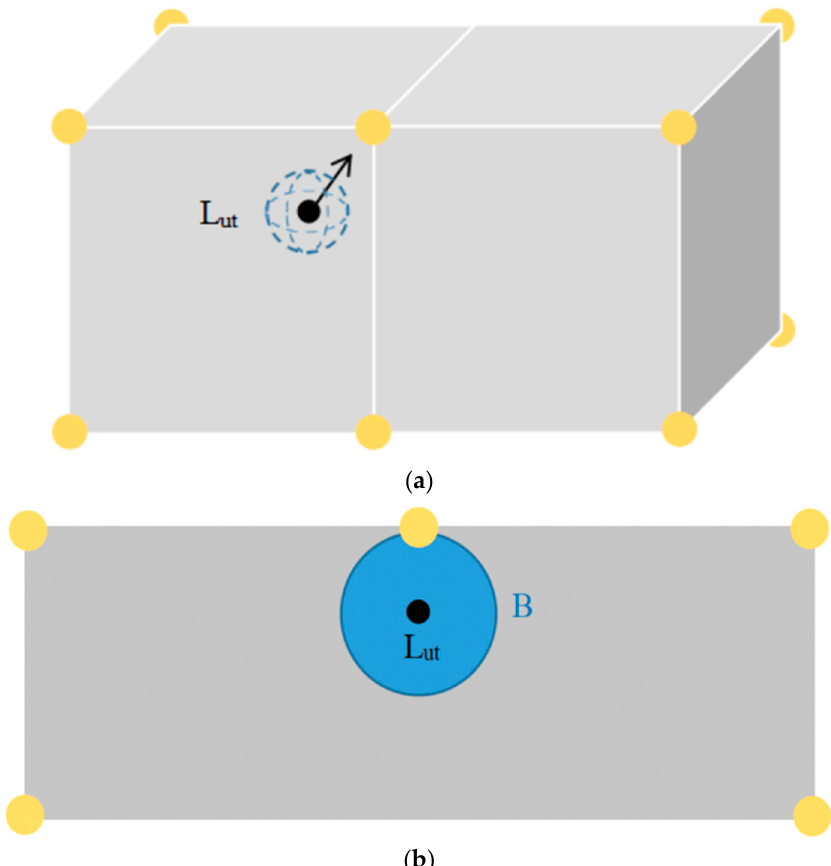
Figure 4. ( a ) Schematic diagram of obstacles and UAV. ( b ) Cross sectional sketch of obstacles and UAV.